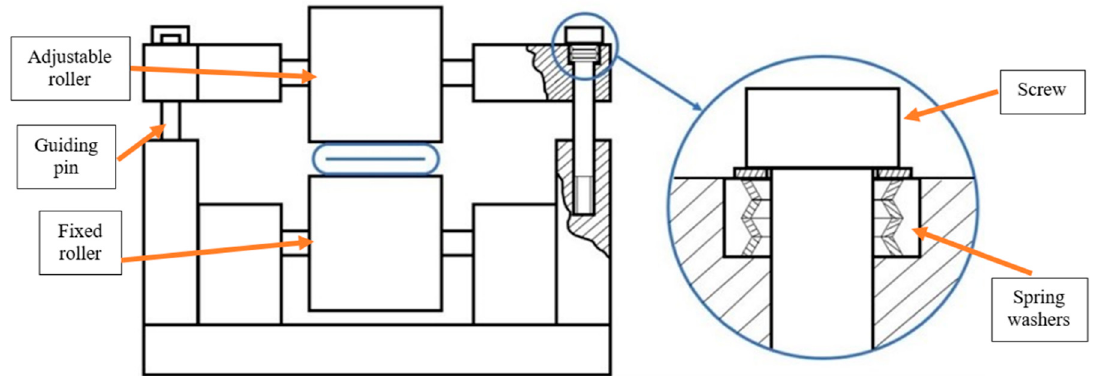
Figure 4. Carriage schematic. Figure 4. Carriage